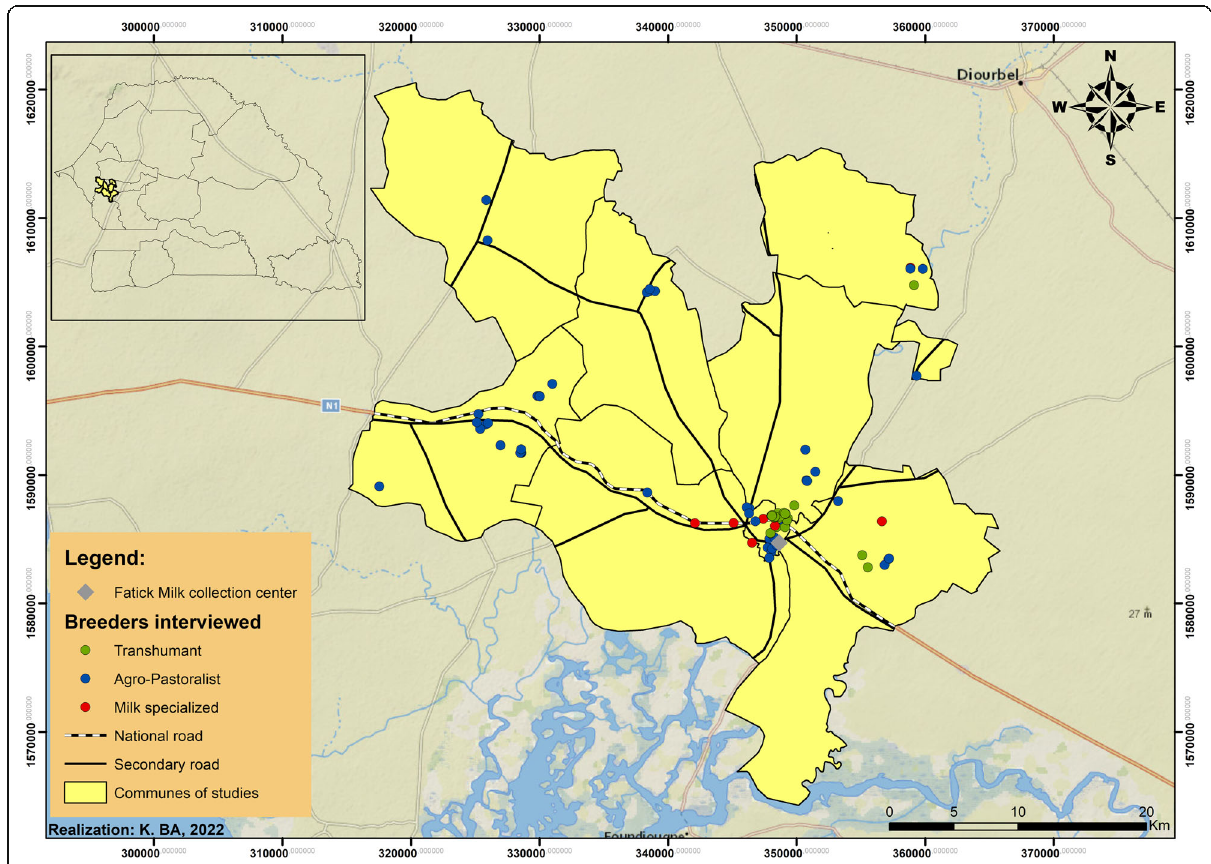
Fig. 1 Location of interviewees by category of livestock farmers and local milk collection centre in the area of Fatick region,